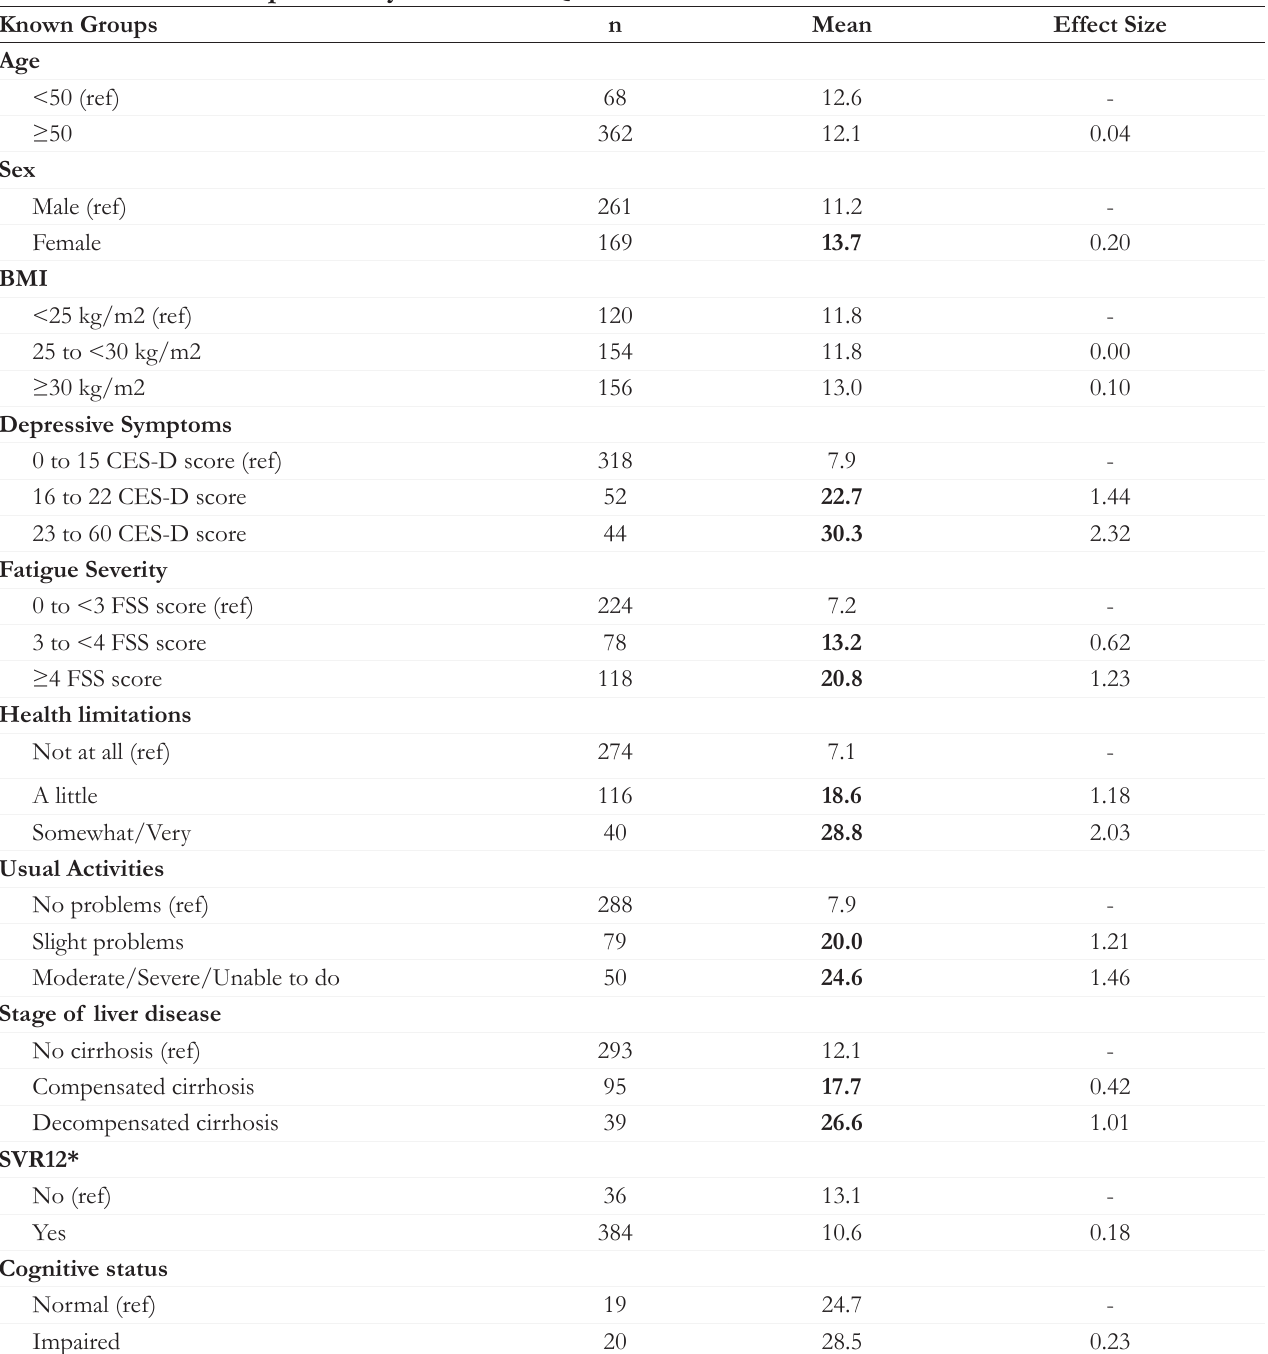
Table 2. Known Groups Validity of HCV-SIQv4 OBSS-IS Known